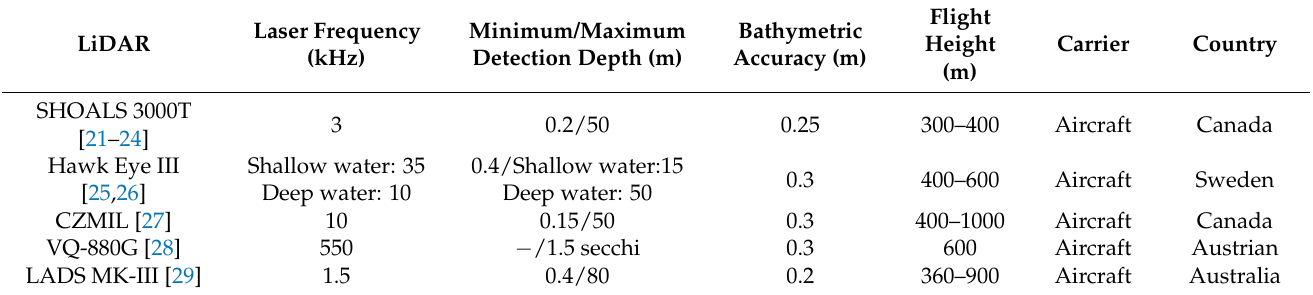
Table 2. Five representative ABL